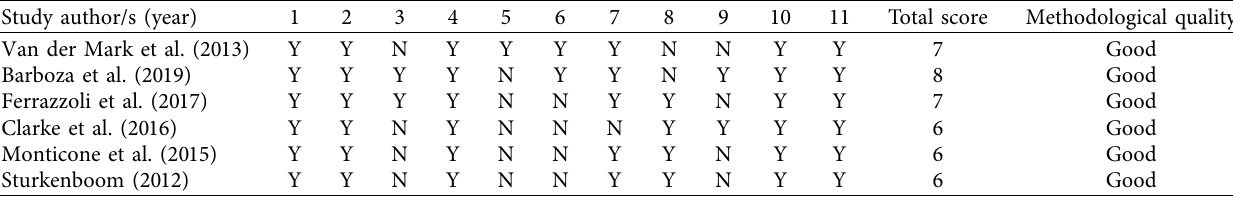
Table 2: The PEDro methodological quality score for studies included ( Y � yes and N � no).